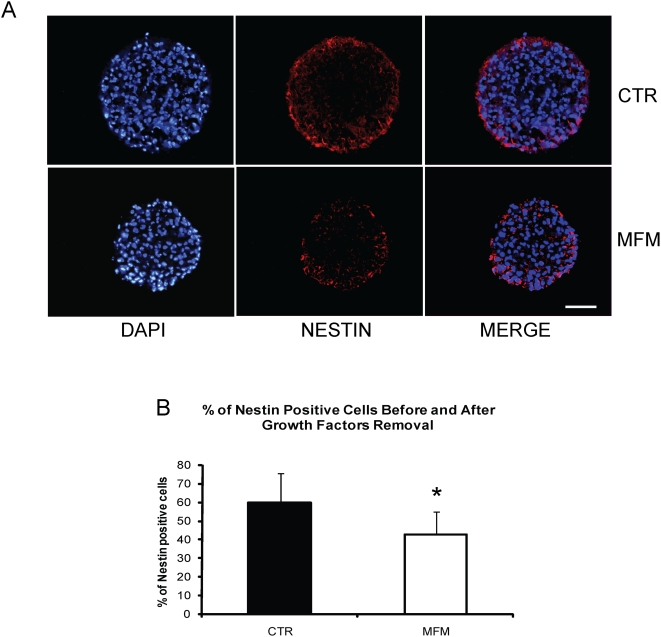
Nestin immunolabeling of hNPC cultured with or without EGF and FGF-2.Nestin positive cells (red) were found mainly in the borders of neurosphere in both CTR and MFM groups (A) Graphic shows the percentage of Nestin positive cells for CTR and MFM groups (B) of hNPC. Note the higher percentage of Nestin positive cells in the CTR group compared with MFM (B) (n = 10, t-Student-test, p<0.05).